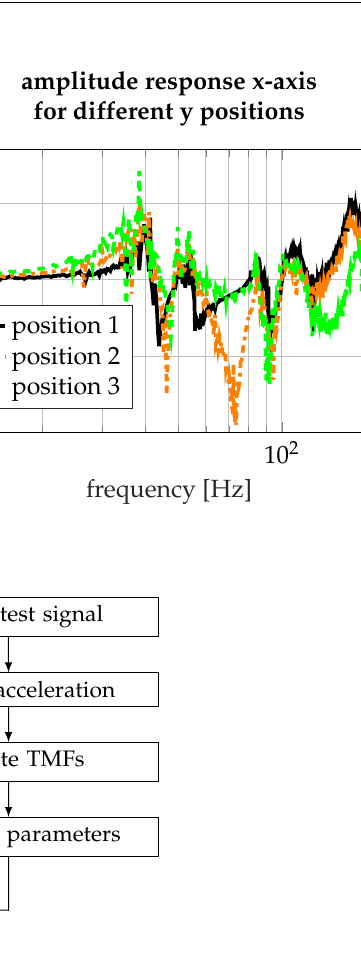
Figure 7. Generation of transmissibility